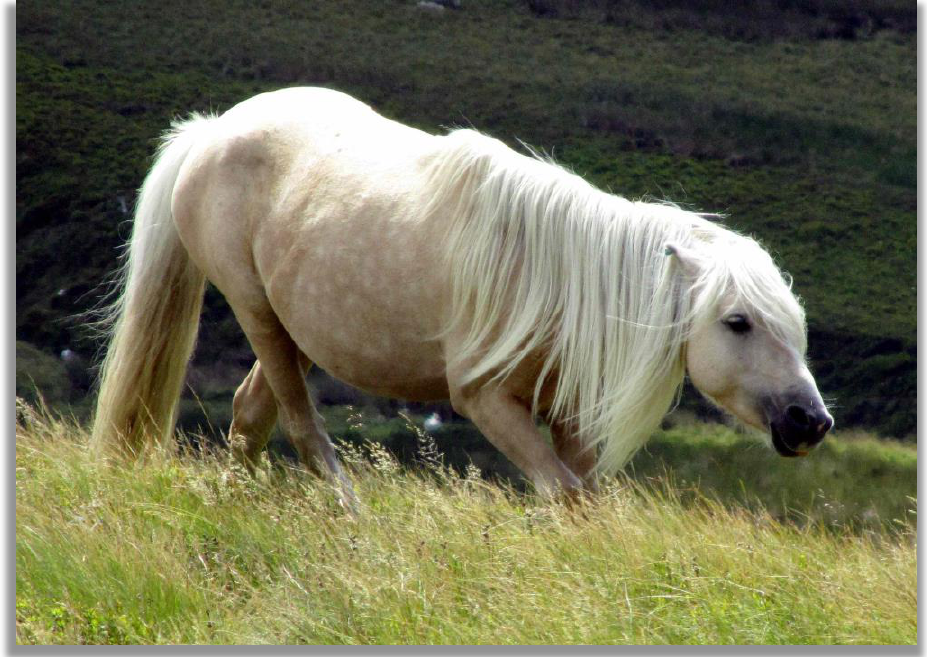
Figure 4. Herding behaviour shown by a Carneddau pony stallion, Carneddau mountain range, North Wales, UK (photo by Christina R. Stanley) .